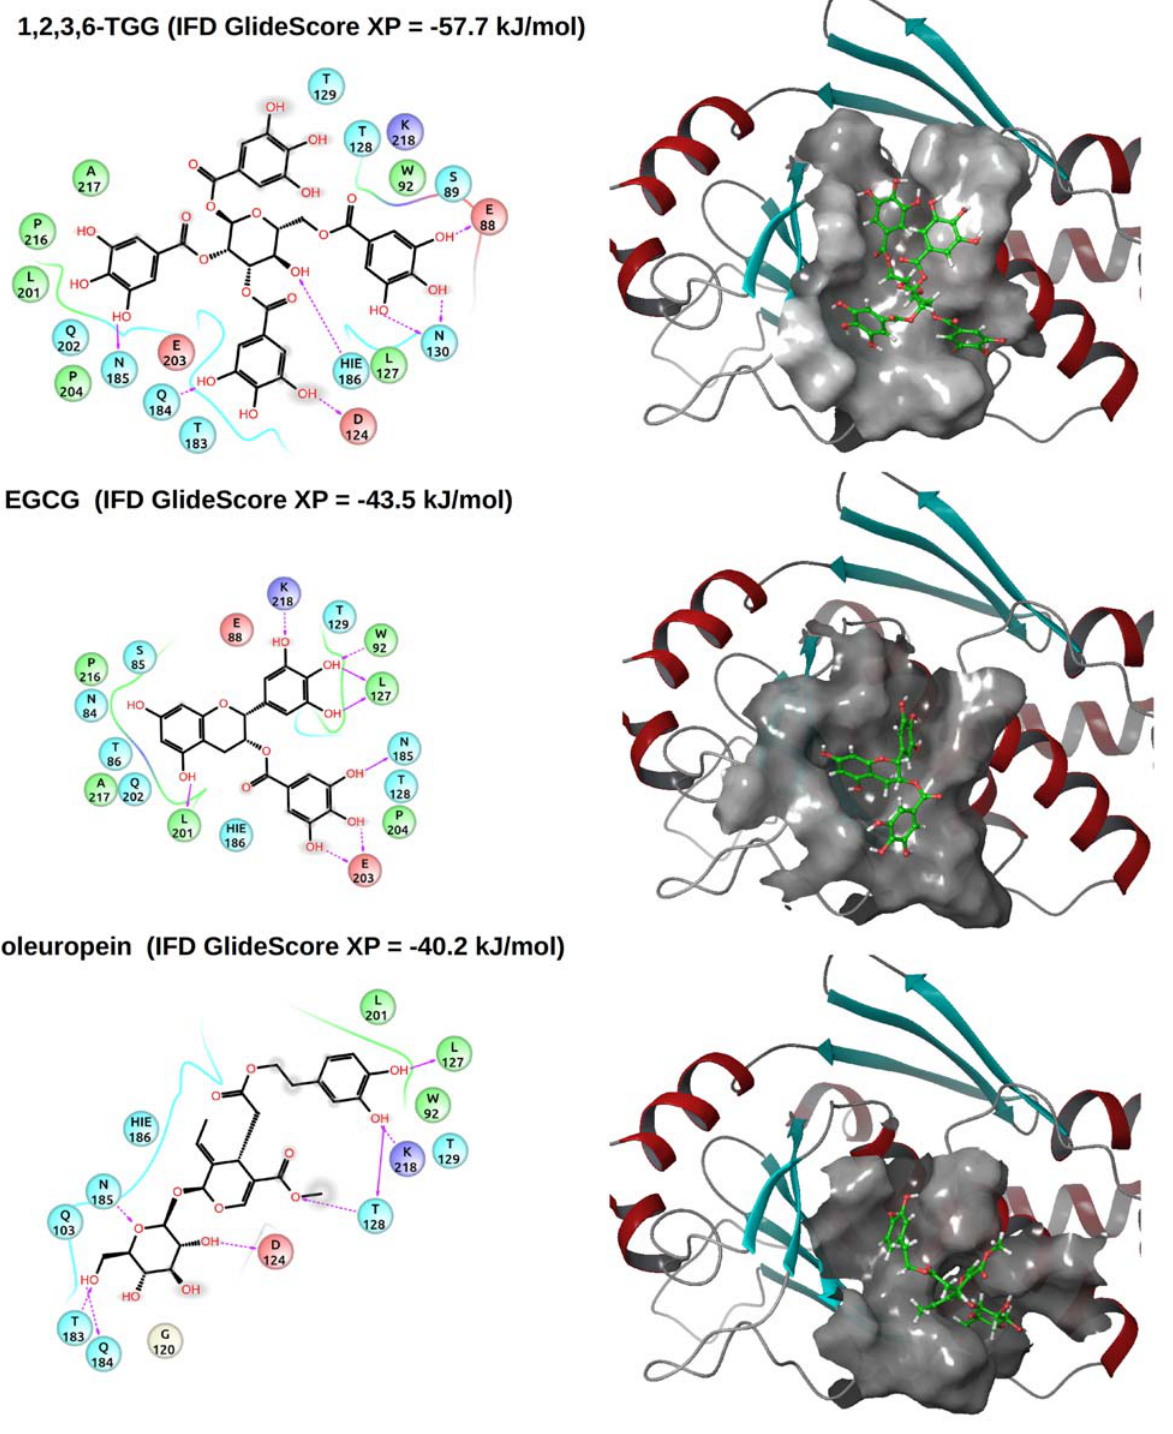
Figure 5 : Interaction maps (left) and poses (right) of 1,2,3,6-TGG, EGCG and oleuropein within binding Site 2 of Ebola